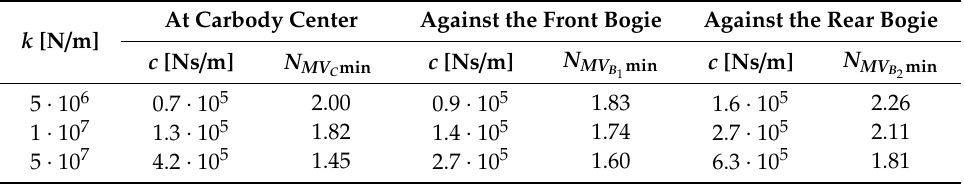
Table 3. The anti-yaw damping values to minimize the ride comfort index at 300 km/h.